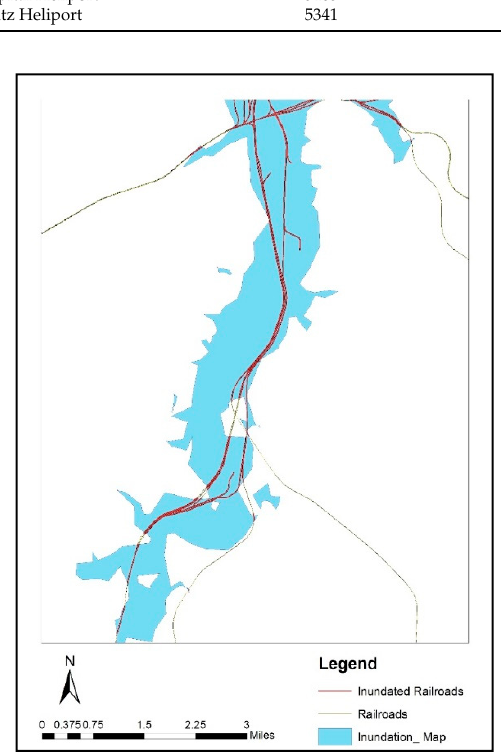
Figure 12. Location of railroad routes under inundation due to the Flood of May 2015. Table 8. List of railroads vulnerable to the flood of May 2017 in Kansas City, Missouri.